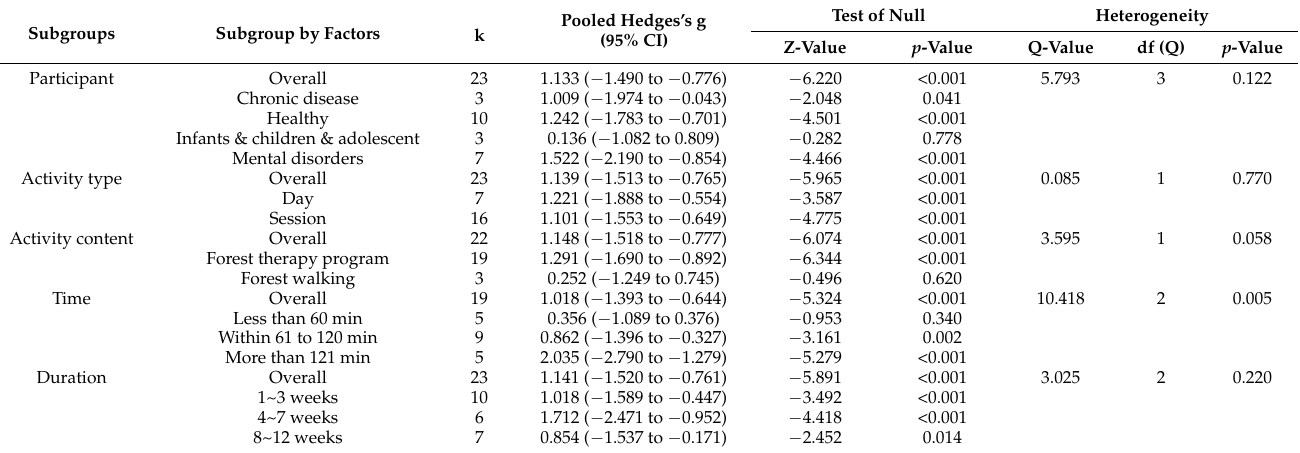
Table 3. Modulator effect analyses for the effects of forest therapy on depression. Subgroups Subgroup by Factors k